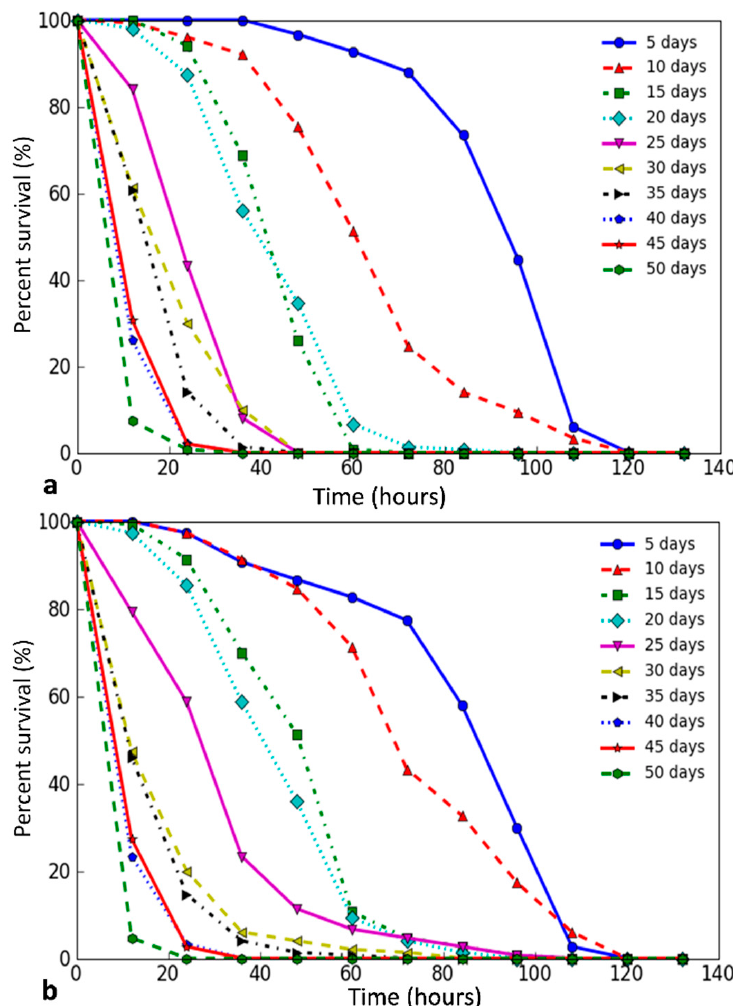
Figure 1. Survival curves of D. melanogaster at different ages. The graphs show the change in survival with an increasing age of flies (5, 10, …, 50 days) when exposed to 20 mM paraquat (( a )—males, ( b )—females).